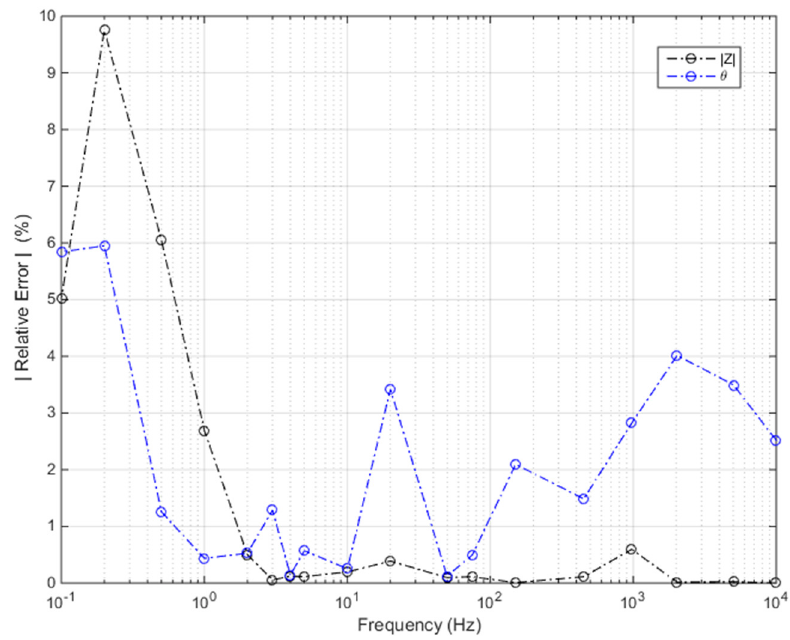
Figure 21. Relative error for estimation of impedance magnitude (black line) and phase (blue line). Table 1. Comparative analysis. EIS: Electrochemical impedance spectroscopy.